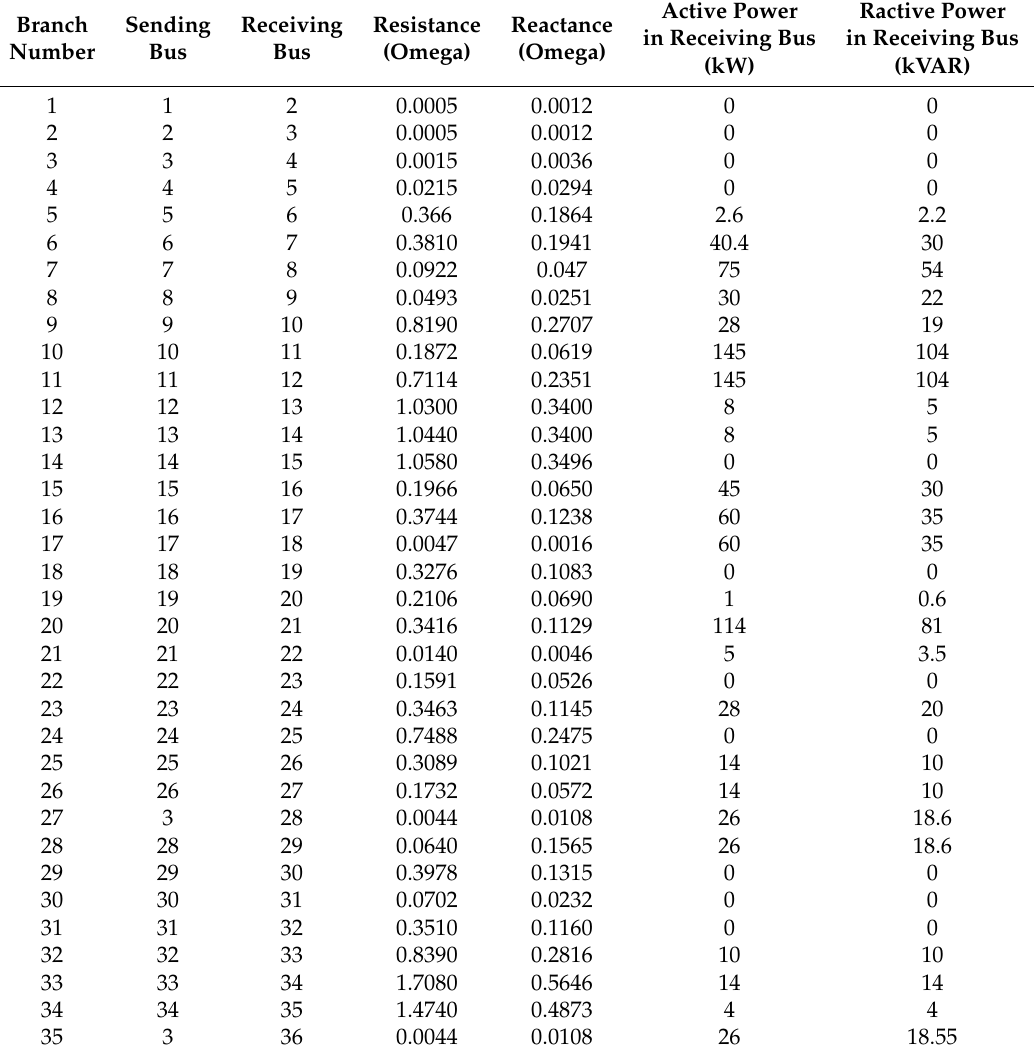
Table A2. Impedance and power of the 66 bus